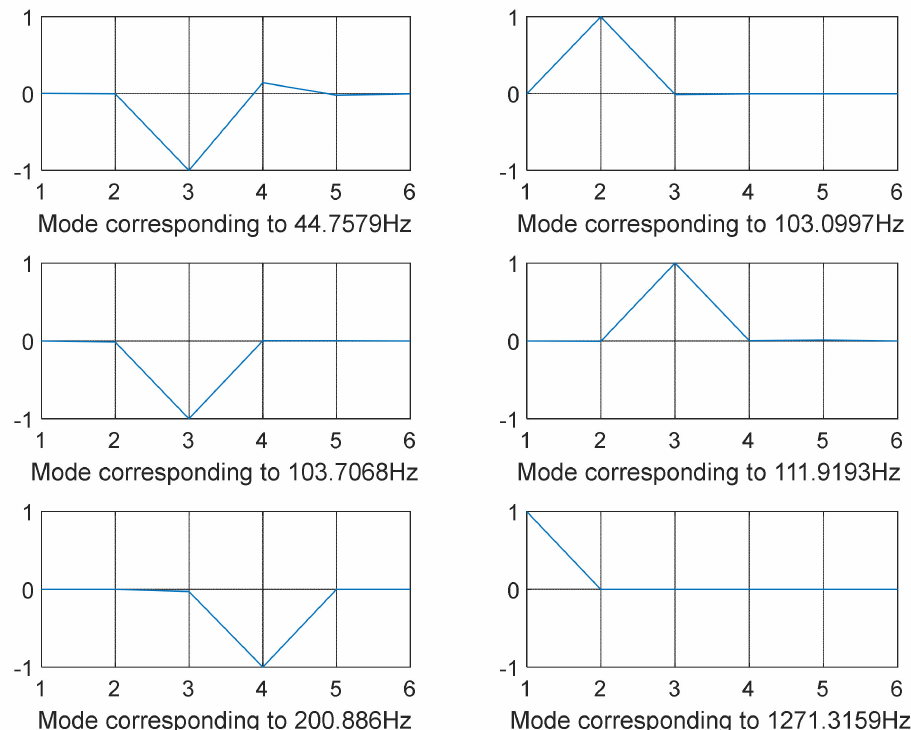
Figure 8. SQP-optimized mode shapes 7–12 (12-DOF model—shaking loads only.